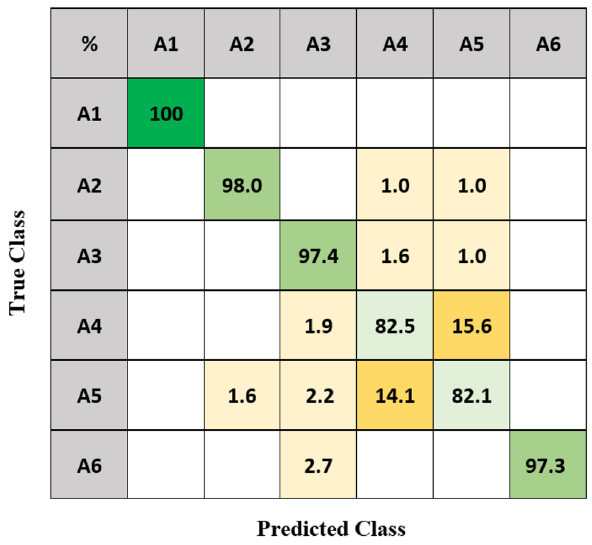
Figure 7. Confusion matrix of Naïve Bayes combiner (decision fusion) with four classifiers.